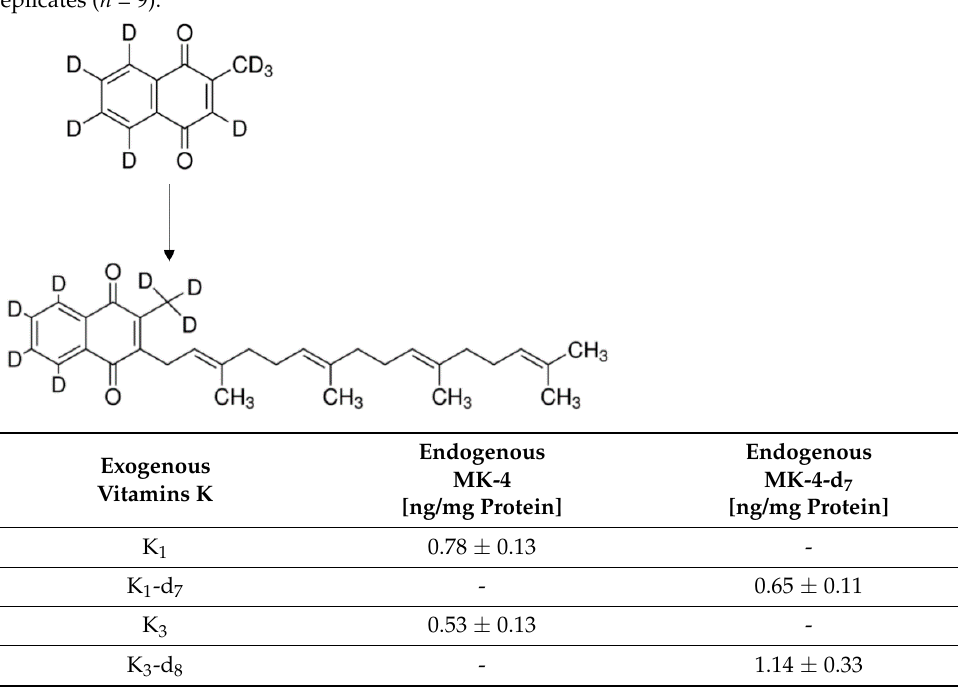
Table 1. A comparison of endogenous production of MK-4/MK4-d 7 in response to K 1 /K 1 -d 7 or K 3 /K 3 -d 8 treatment. RAW 264.7 cells were incubated 48 h with vitamins K 1 /K 1 -d 7 or K 3 /K 3 - d 8 . Then, the concentration of MK-4/MK-4-d 7 was measured in cell lysates using the UHPLC-MS/MS technique. Data are shown as median ± SD of three independent experiments with technical replicates ( n =